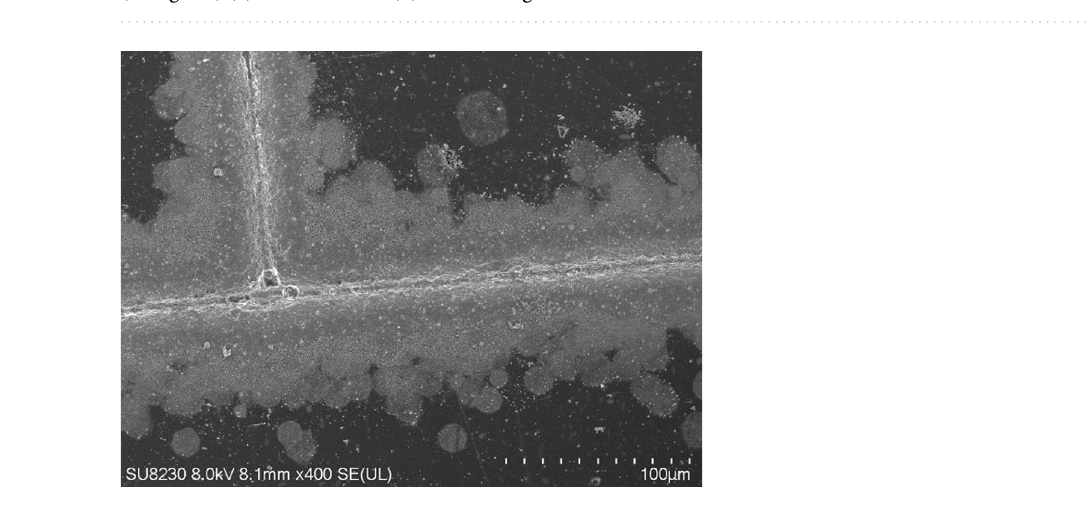
Figure 5. Measurements of the pattern, printed using S2 Ink, using Scanning Electron Microscopy images (Auriga 60) ( a ) the line width; ( b ) the line height.